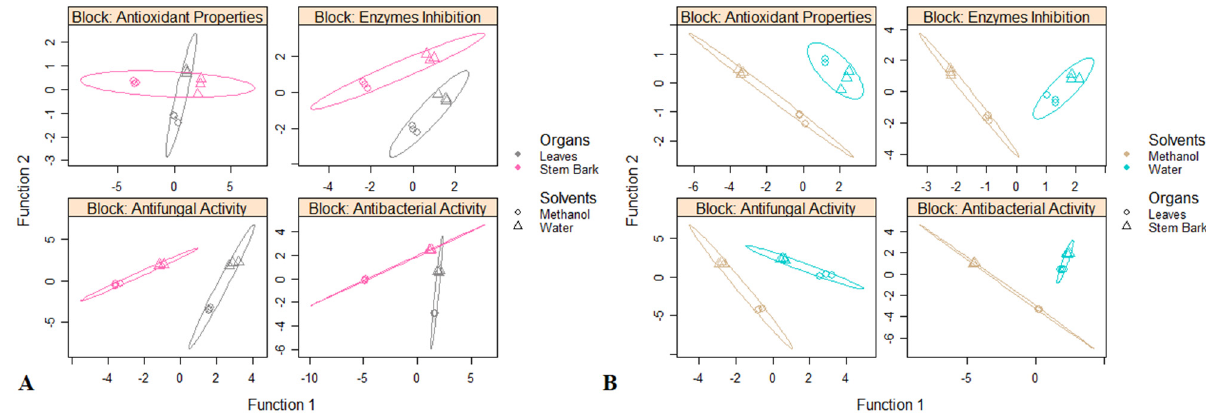
Figure 5. Score plot of the multi-block discriminant analysis on P. kotschyi bioactive antioxidant, enzyme inhibitory, antifungal, and antibacterial activities. ( A ): Discrimination of the samples according to the parts. ( B ): Discrimination of the samples according to the solvents of extraction.